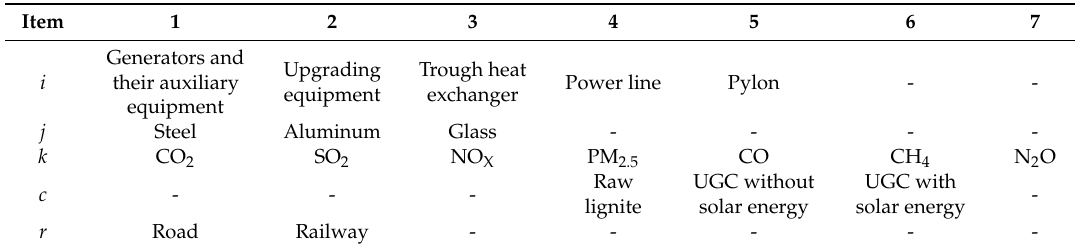
Table 2. The meaning of the numbers.